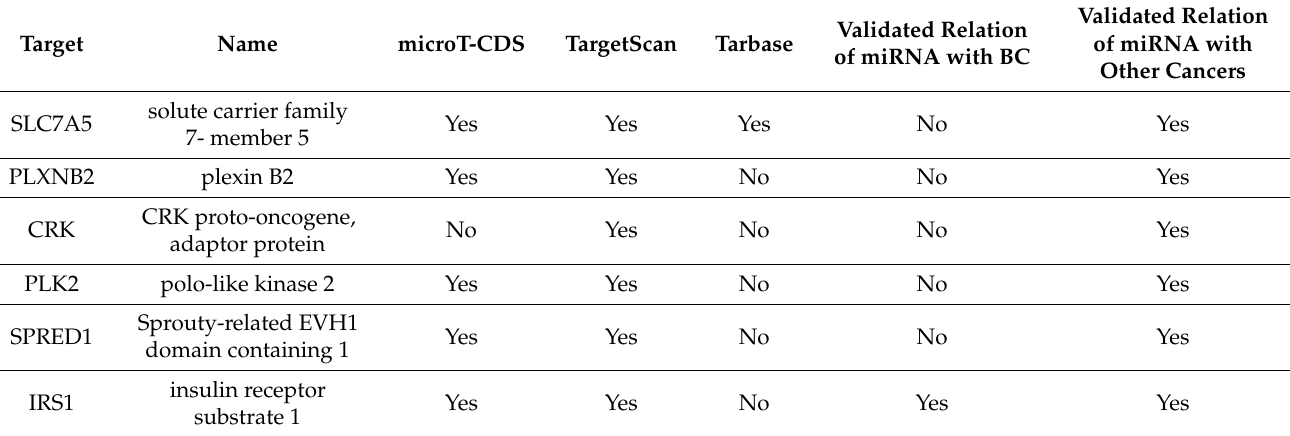
Table 1. Selection Criteria of miR-126 Potential mRNA Targets in BC.